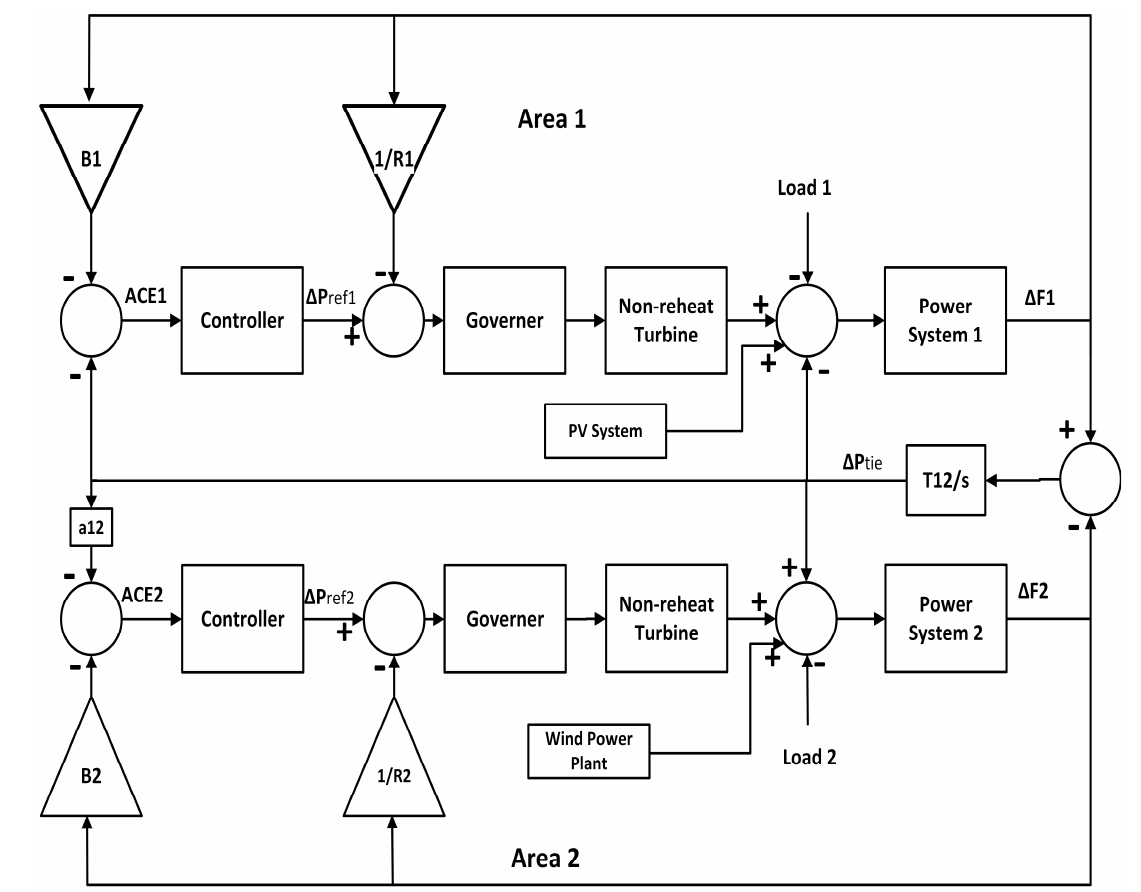
Figure 1. The components of the studied interconnected two-area non-reheat thermal power system.